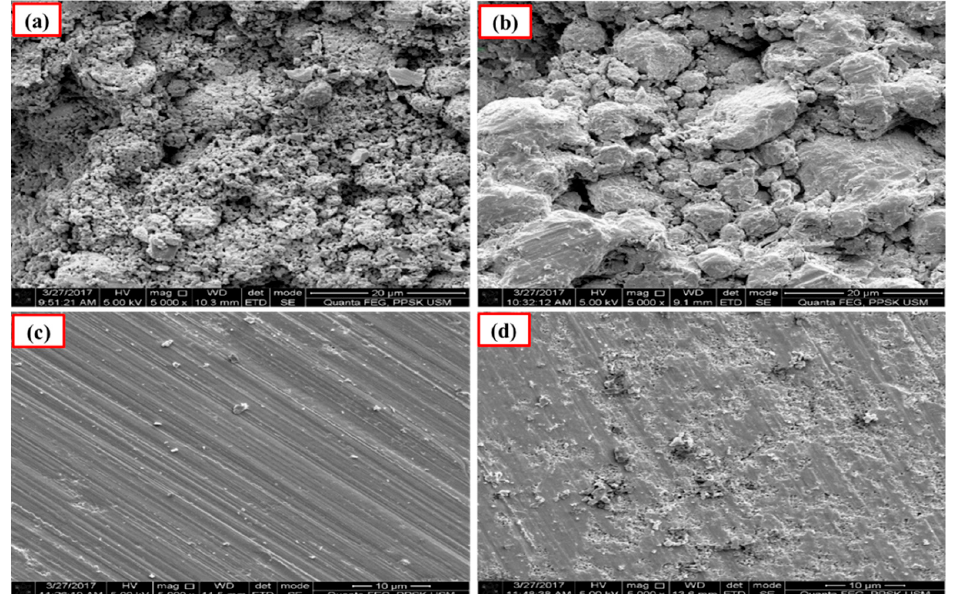
Figure 6. SEM images of polished Ca-SZ(CS) sintered for 2 h at ( a ) 1200 °C; ( b ) 1300 °C; ( c ) 1400 °C and ( d ) 1500 °C.